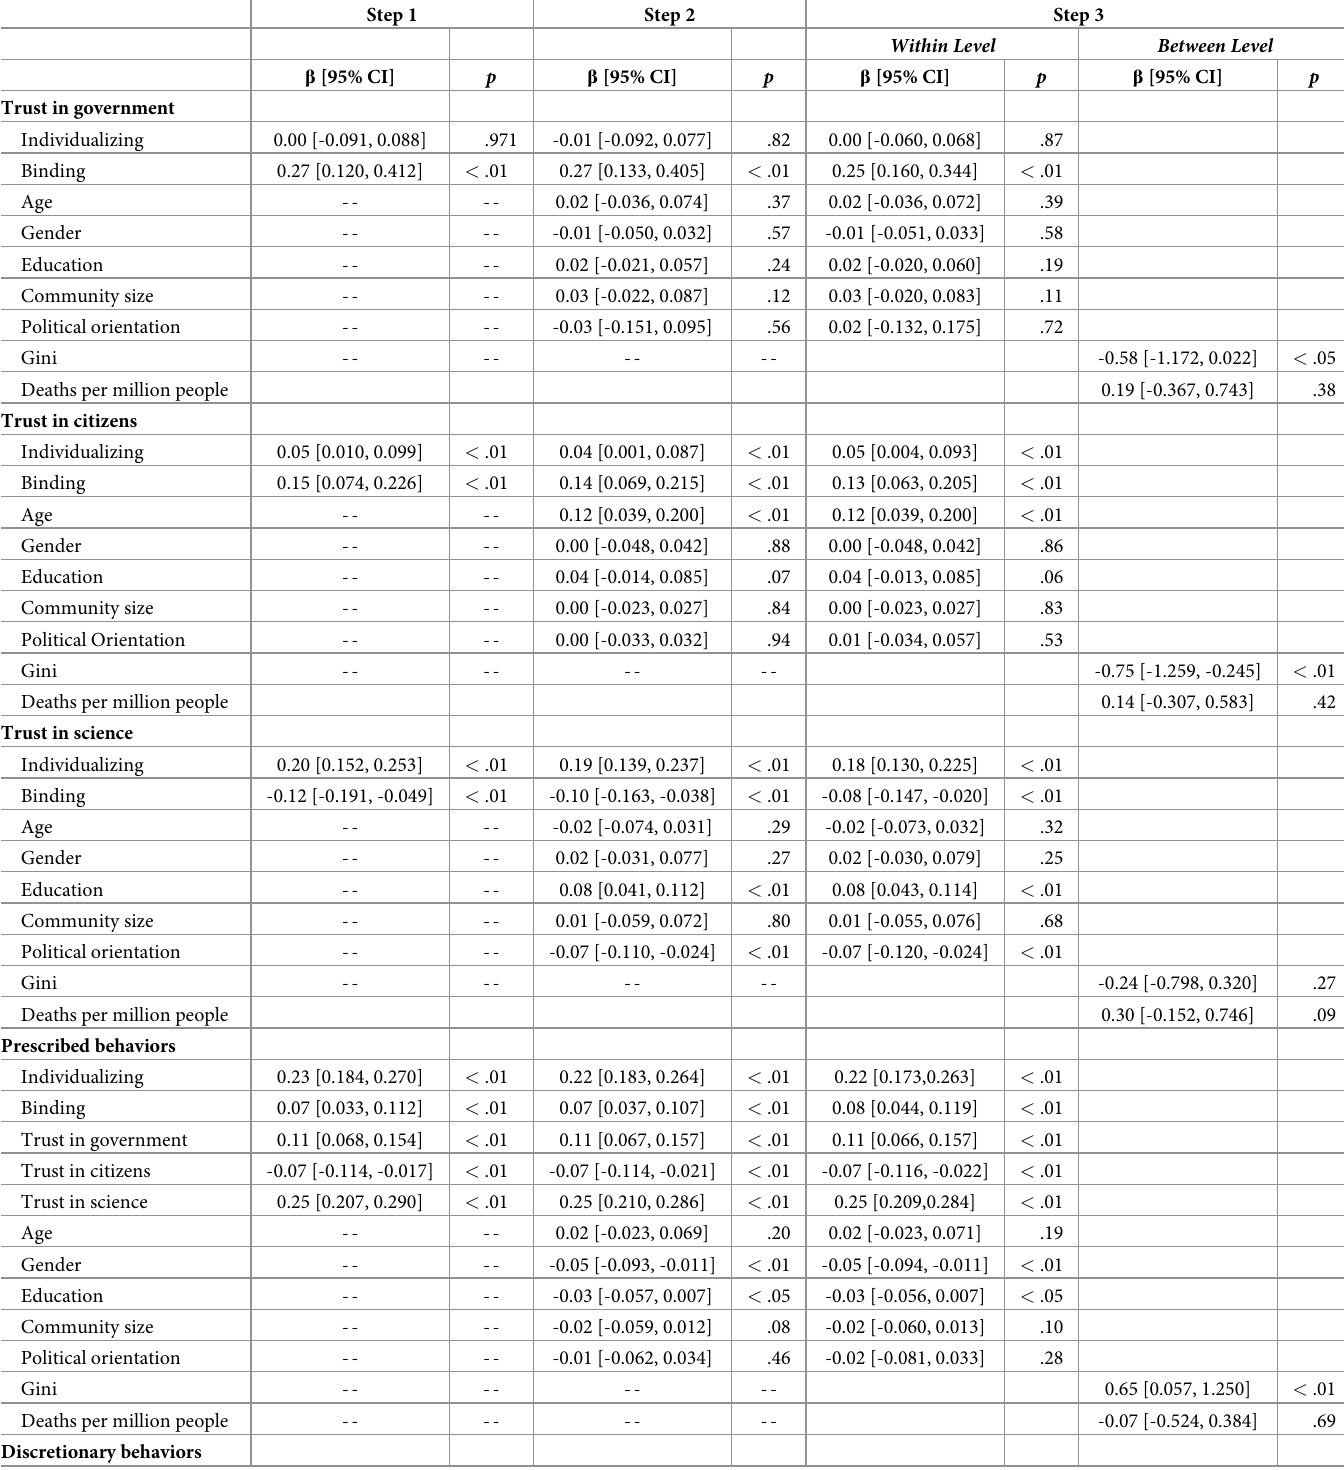
Table 1. Estimated parameters of the three models tested. Step 1 is the model depicted in Fig 1, Step 2 includes the individual level control variables, step 3 includes the country-level variables. Step 1 Step 2 Step 3 Within